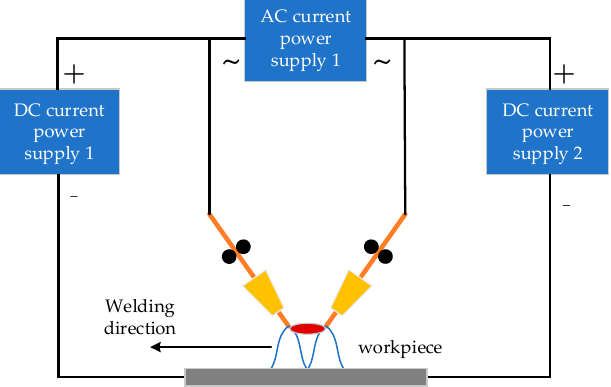
Figure 4. Dual-wire dynamic triple-arc welding process.